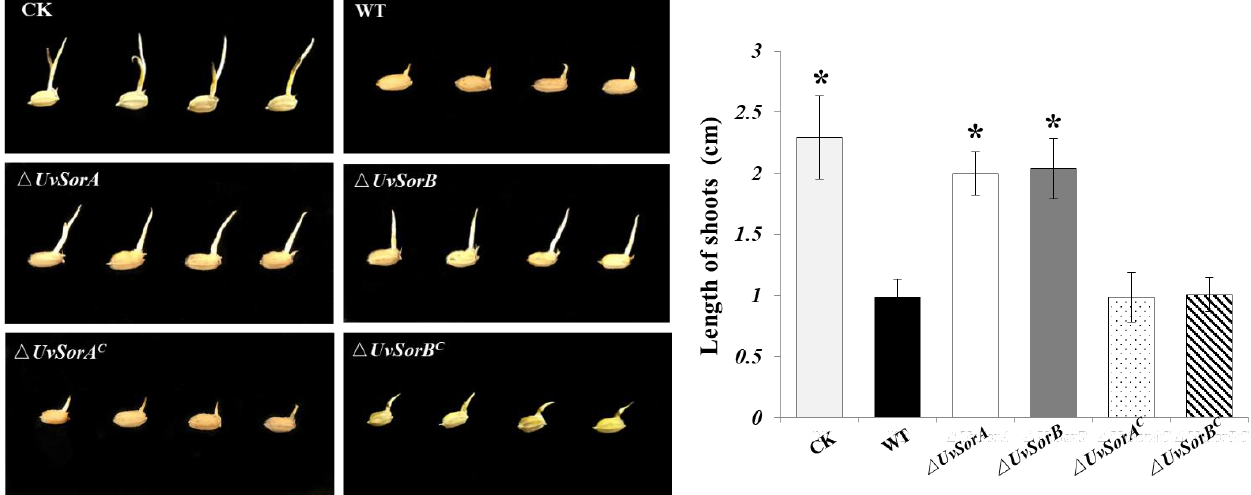
Figure 11. The growth of rice germinated seeds treated with testing culture filtrates. The rice seeds were soaked in 25 mL culture filtrates of tested strains in 100 mL-conical flasks at 28 °C for 7 days (left panel); Statistical analysis of germinated rice seeds (right panel). The length of shoots was measured after the incubation. Three independent biological experiments were performed with three replicates each time. Error bars represent the standard deviation, and the asterisk (*) represents a significant difference at p < 0.05.